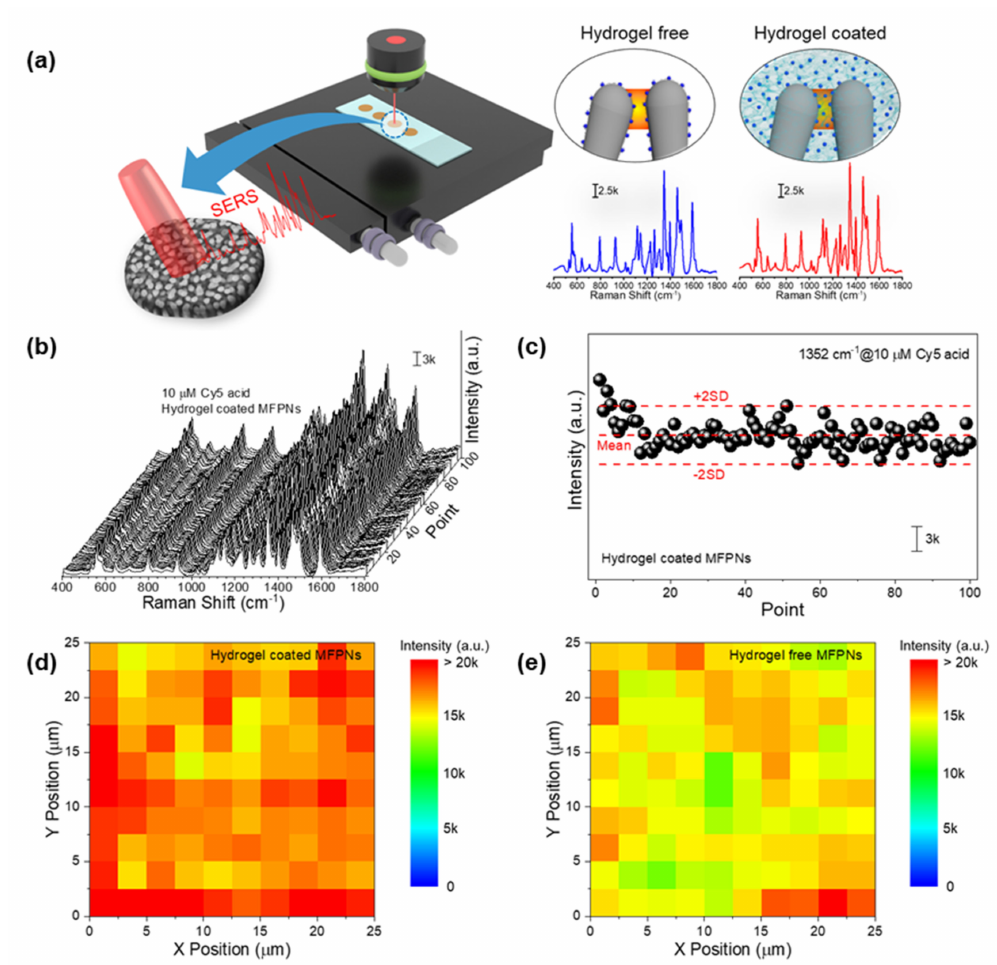
Figure 3. Reproducibility of metal film (Au/Ag) over polyimide nanopillars (MFPNs) with and without the hydrogel skin. ( a ) Strategic diagram of the systematical measurement for Raman mapping. ( b ) Raman mapping spectra and ( c ) corresponding Raman intensities at 1352 cm − 1 of 10 µ M Cyanine5 (Cy5) acid on hydrogel-coated MFPNs. Contour plot for the Raman mapping spectra of 10 µ M Cy5 acid on MFPNs ( d ) with and ( e ) without hydrogel